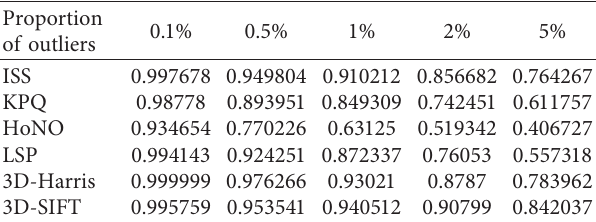
of the key point Table 11: The outlier repetition rate r density tection algorithm on the random view data